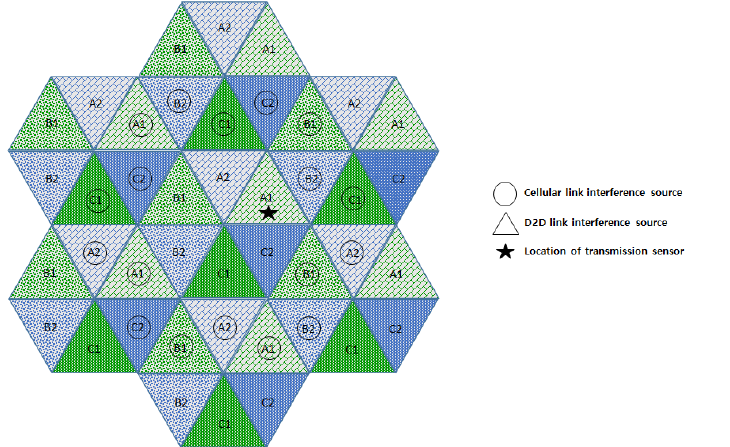
Figure 7. Interference sources to the target cellular link in a semi-static